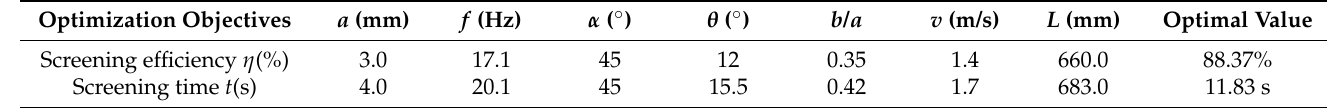
Table 8. Screening parameters verified with